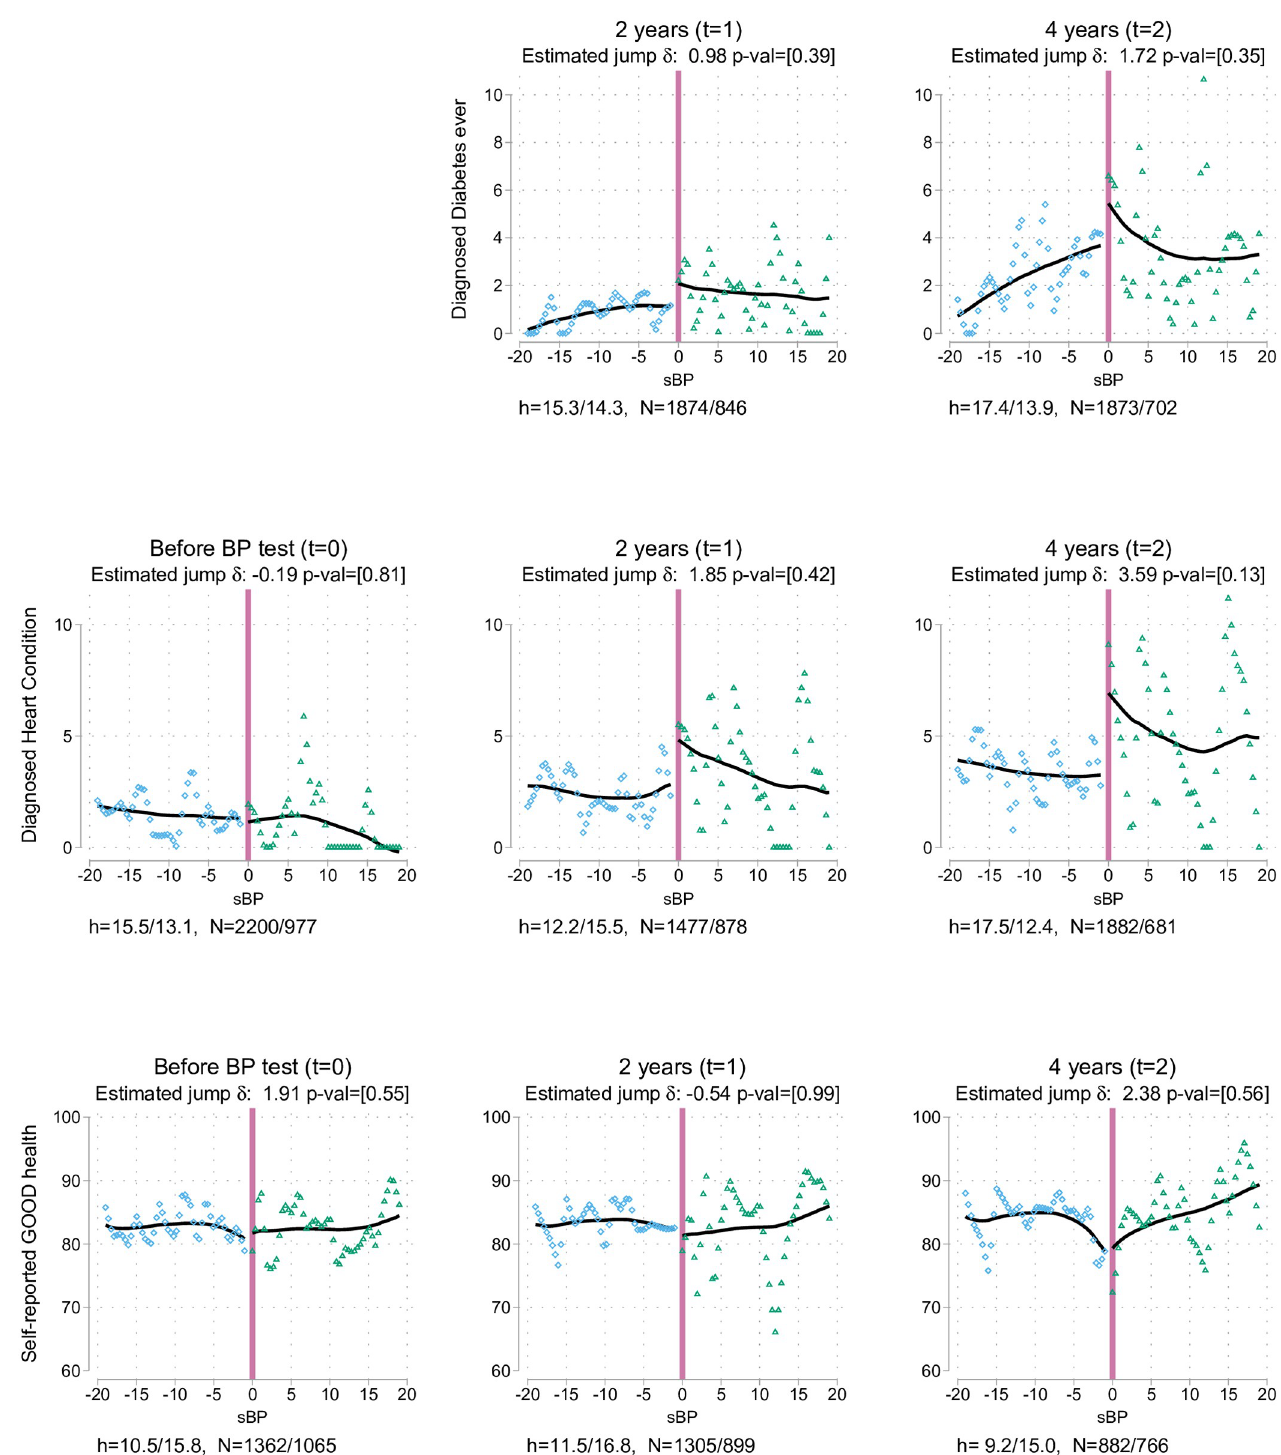
Fig 3. Impacts on diagnosis of diabetes, heart conditions, and self-reported good health.